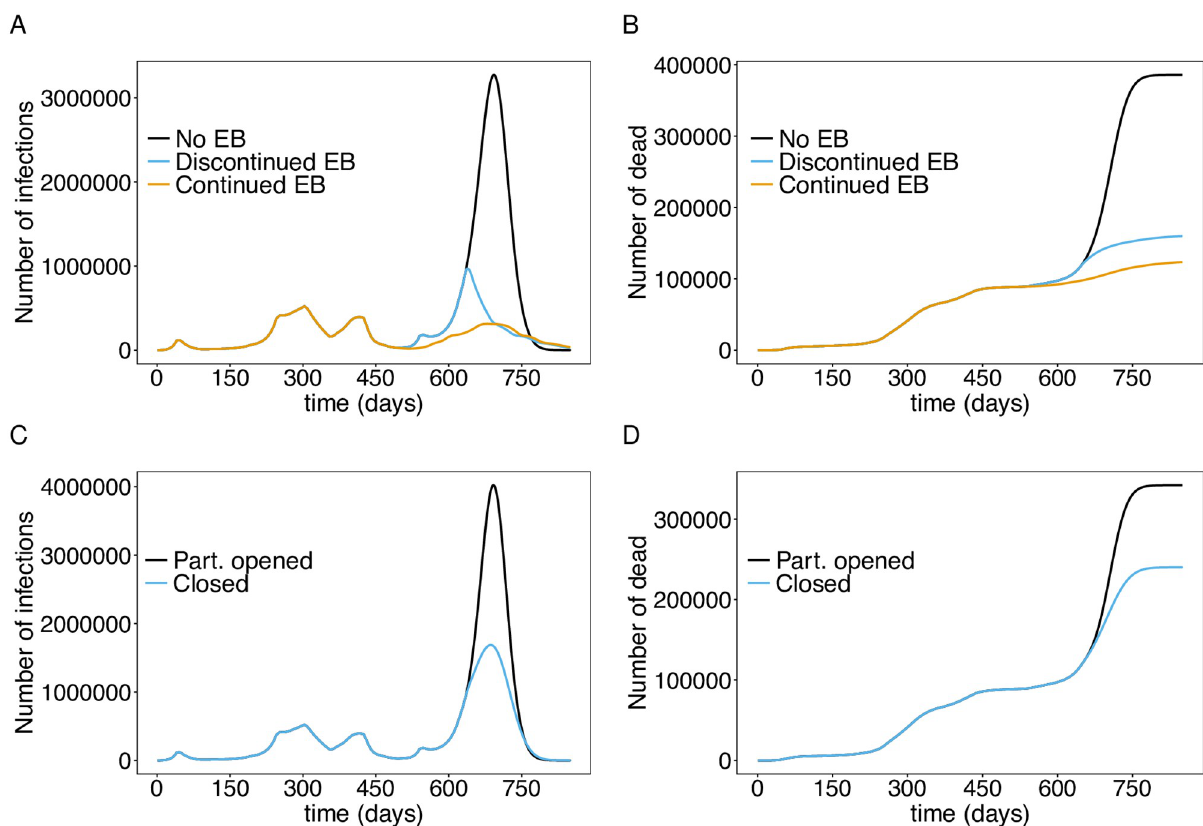
Fig 4. Impact of emergency brake (EB) and schooling from home. Shown are the total numbers of infected ( E , P , I , L ) individuals (A) and deaths (B) assuming a continuation of the current interventions, a second emergency brake starting Nov. 22 which is continued to the end of the simulation, and the hypothetical effect of a continuation of the emergency brake implemented in April 2021. (C) shows the total number of infections under the continuation of the current interventions and additional schooling from home (closing schools) until the end of the simulation runs and the corresponding cumulative number of deaths (D). The parameters used for the simulations are listed in S1 to S11